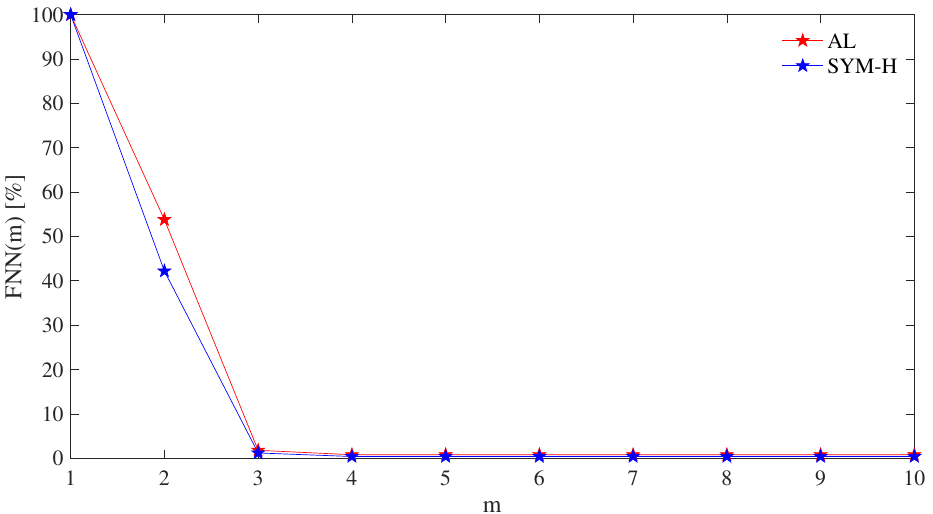
Figure 4. Percentage of false nearest neighbors as a function of the embedding dimension m